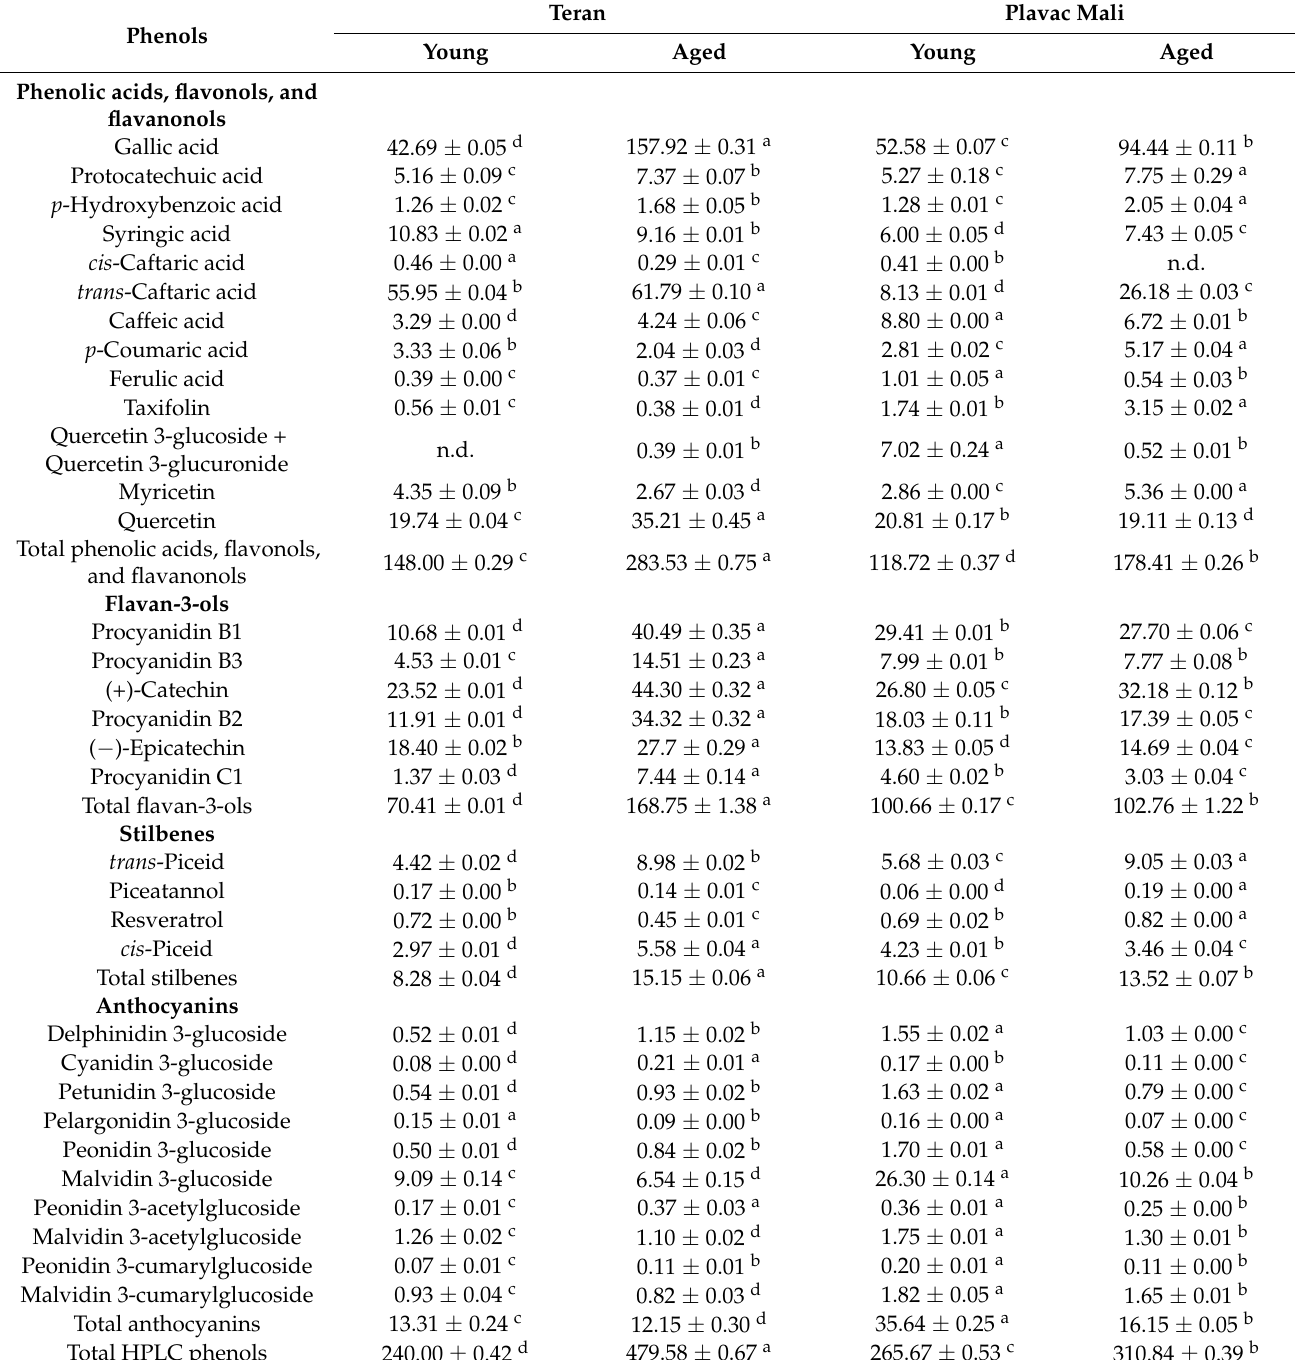
n.d.—not detected; young red wines produced with standard 7–8 days maceration and aged red wines pro- duced with prolonged maceration (15–30 days) and maturation in oak barrels. Each value represents